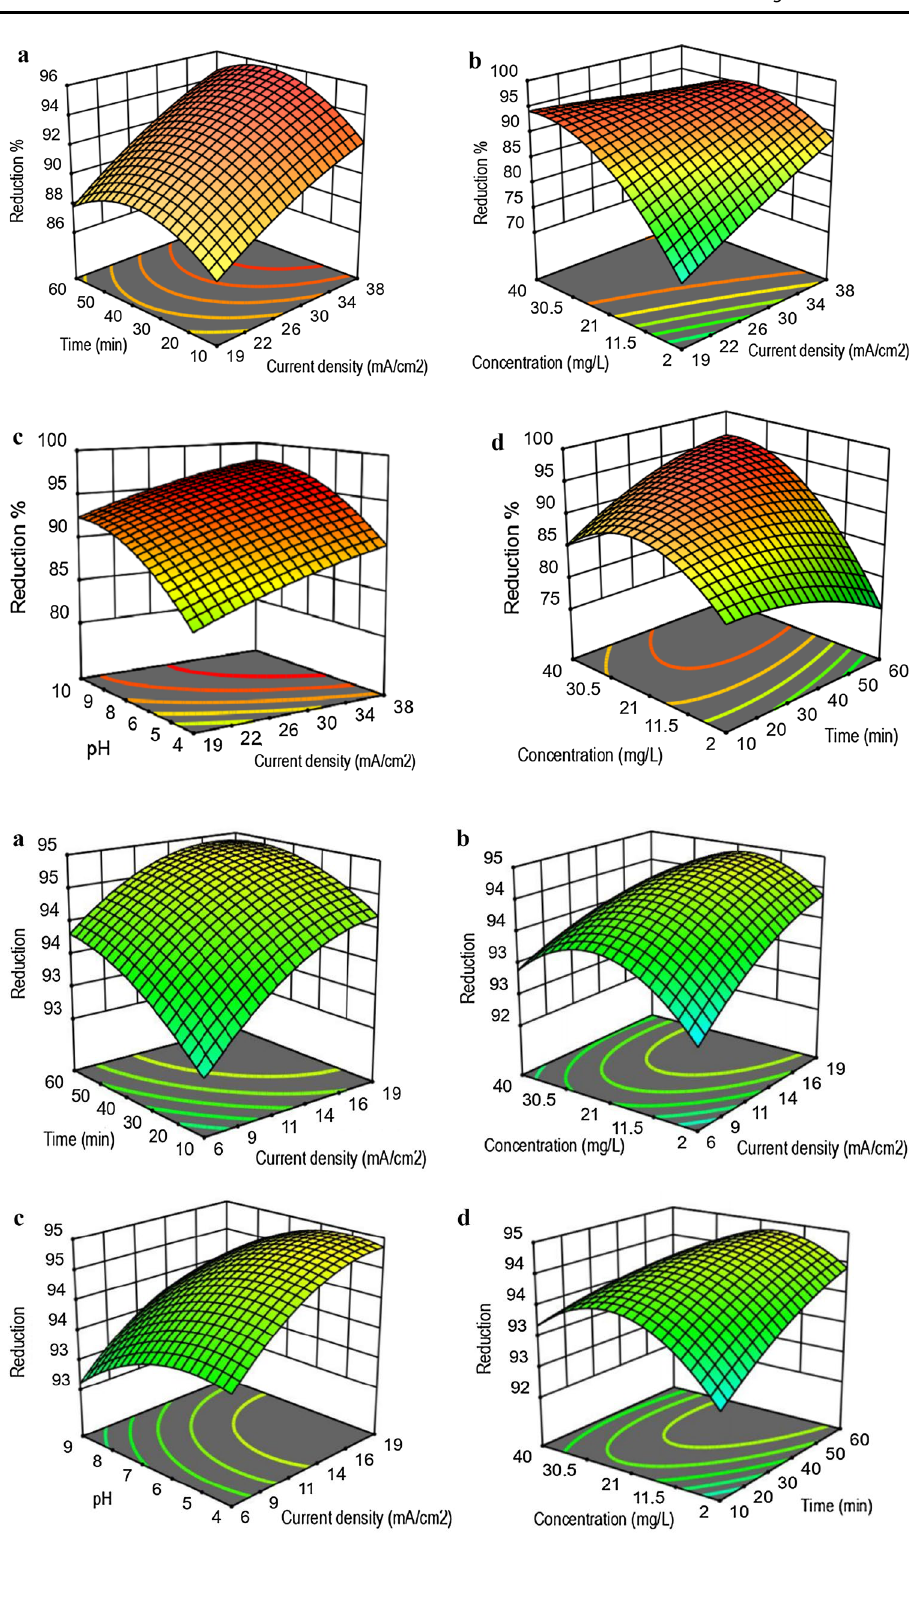
Fig. 7 Surface plots with con- tour as a function of a treatment time and current density at pH 6.5 and initial concentration 21 mg/L, b initial concentration and current density at pH 6.5 and treatment time 35 min, c pH and current density at initial concentration of 21 mgF/L and time 35 min, d concentration and time at current density 28 mAcm −2 and pH 6.5